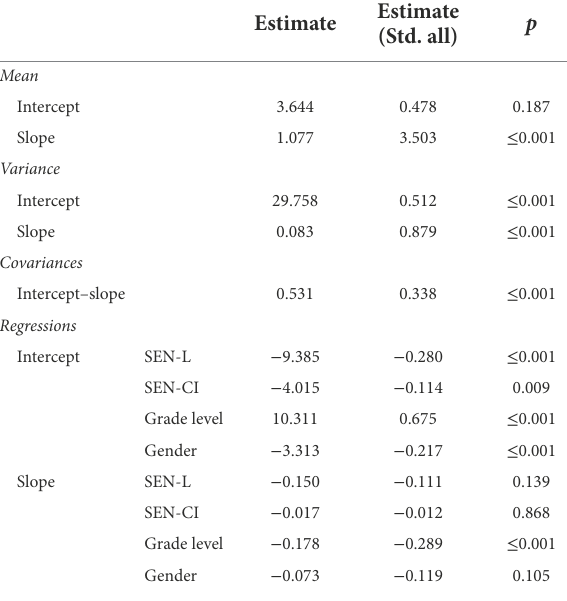
TABLE 9 Parameter estimates for linear latent growth model (Model 2).